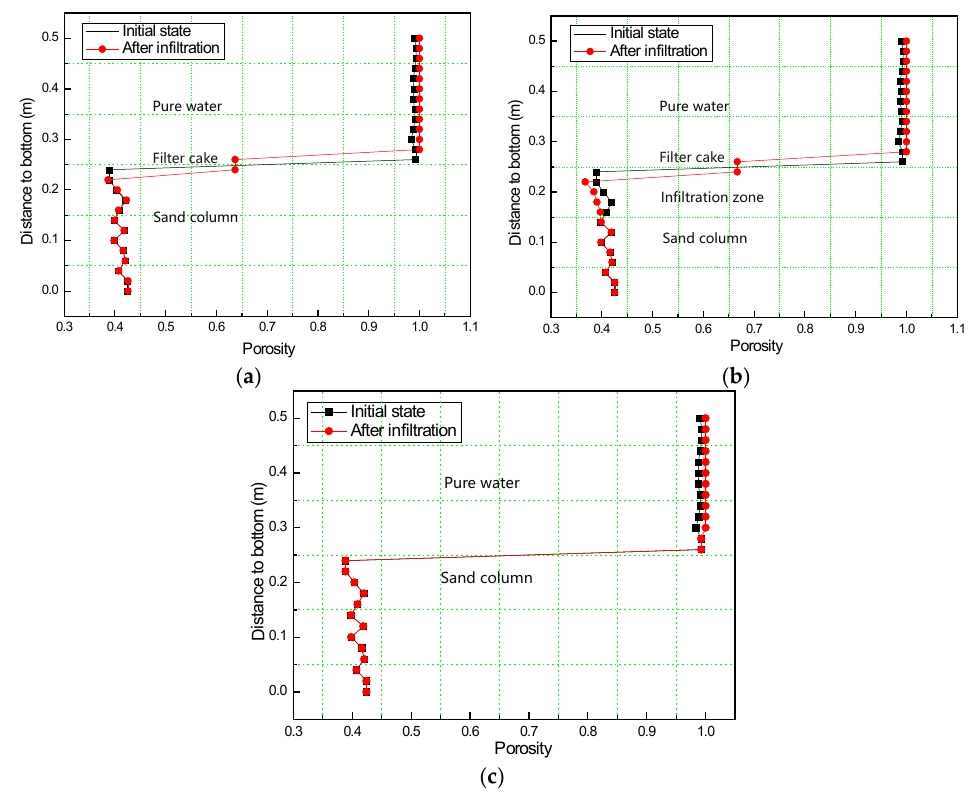
Figure 8. Porosity distribution along the infiltration column of initial state and after infiltration: ( a ) Type I; ( b ) Type II; ( c ) Type III.